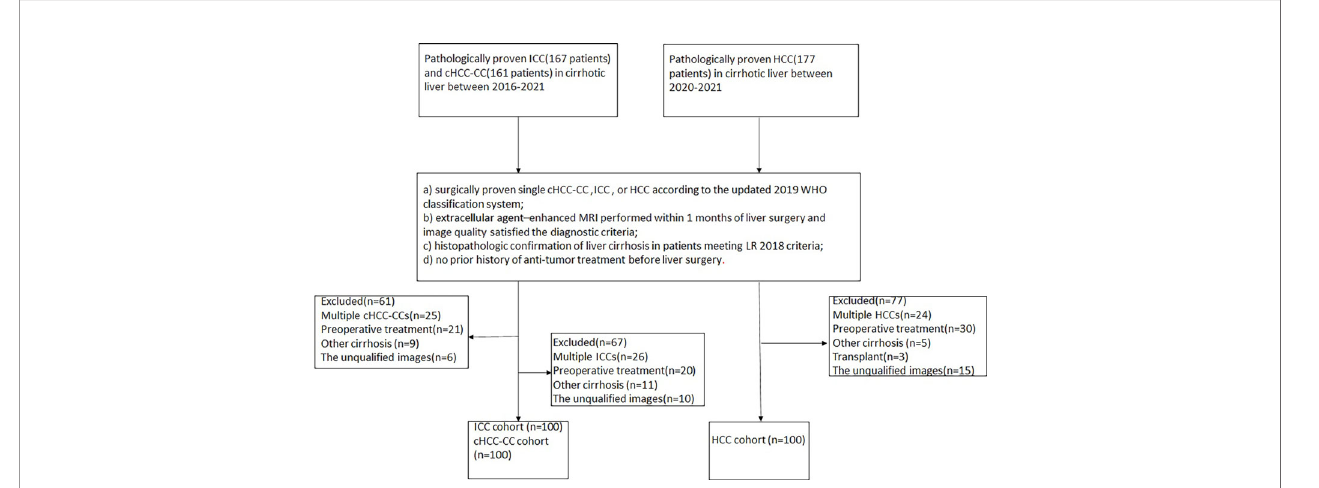
FIGURE 1 | Flowchart of the study cohort. HCC, hepatocellular carcinoma; ICC, intrahepatic cholangiocarcinoma; cHCC-CCA, combined hepatocellular